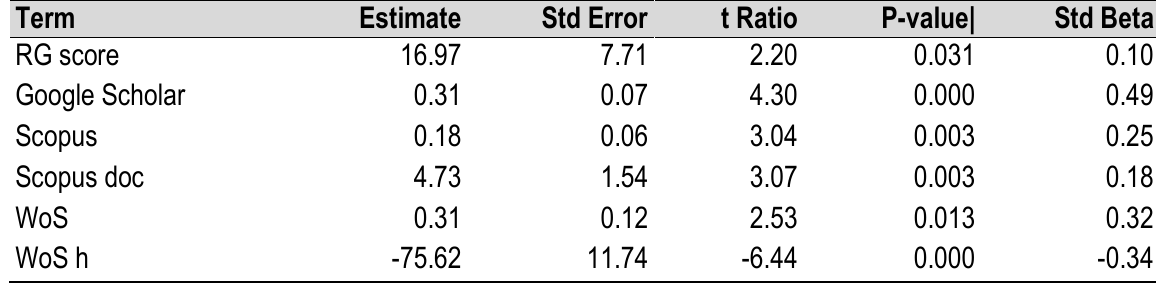
Table 2. A stepwise regression model (backward) predicting Research Interest